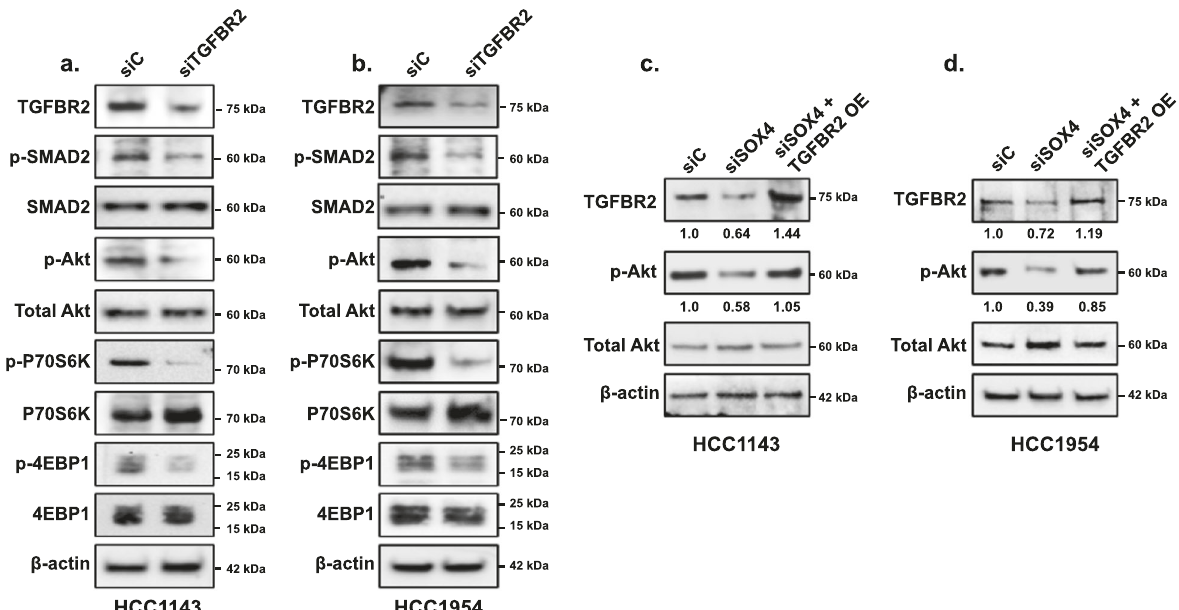
Fig. 3 SOX4 mediates activation of the PI3K pathway through TGFBR2. a Western blot analysis showing downregulation of the PI3K pathway activity as indicated by decreased expression of PI3K pathway downstream components in HCC1143 following siTGFBR2 treatment (96 h) relative to siControl treatment. p-SMAD2 downregulation is used as a positive control for TGFBR2 protein depletion. b Similar results were observed in HCC1954 cells. c Lentiviral overexpression of TGFBR2 restores pAkt levels in siSOX4 (96 h) treated HCC1143 cells. d Consistent results were observed in HCC1954